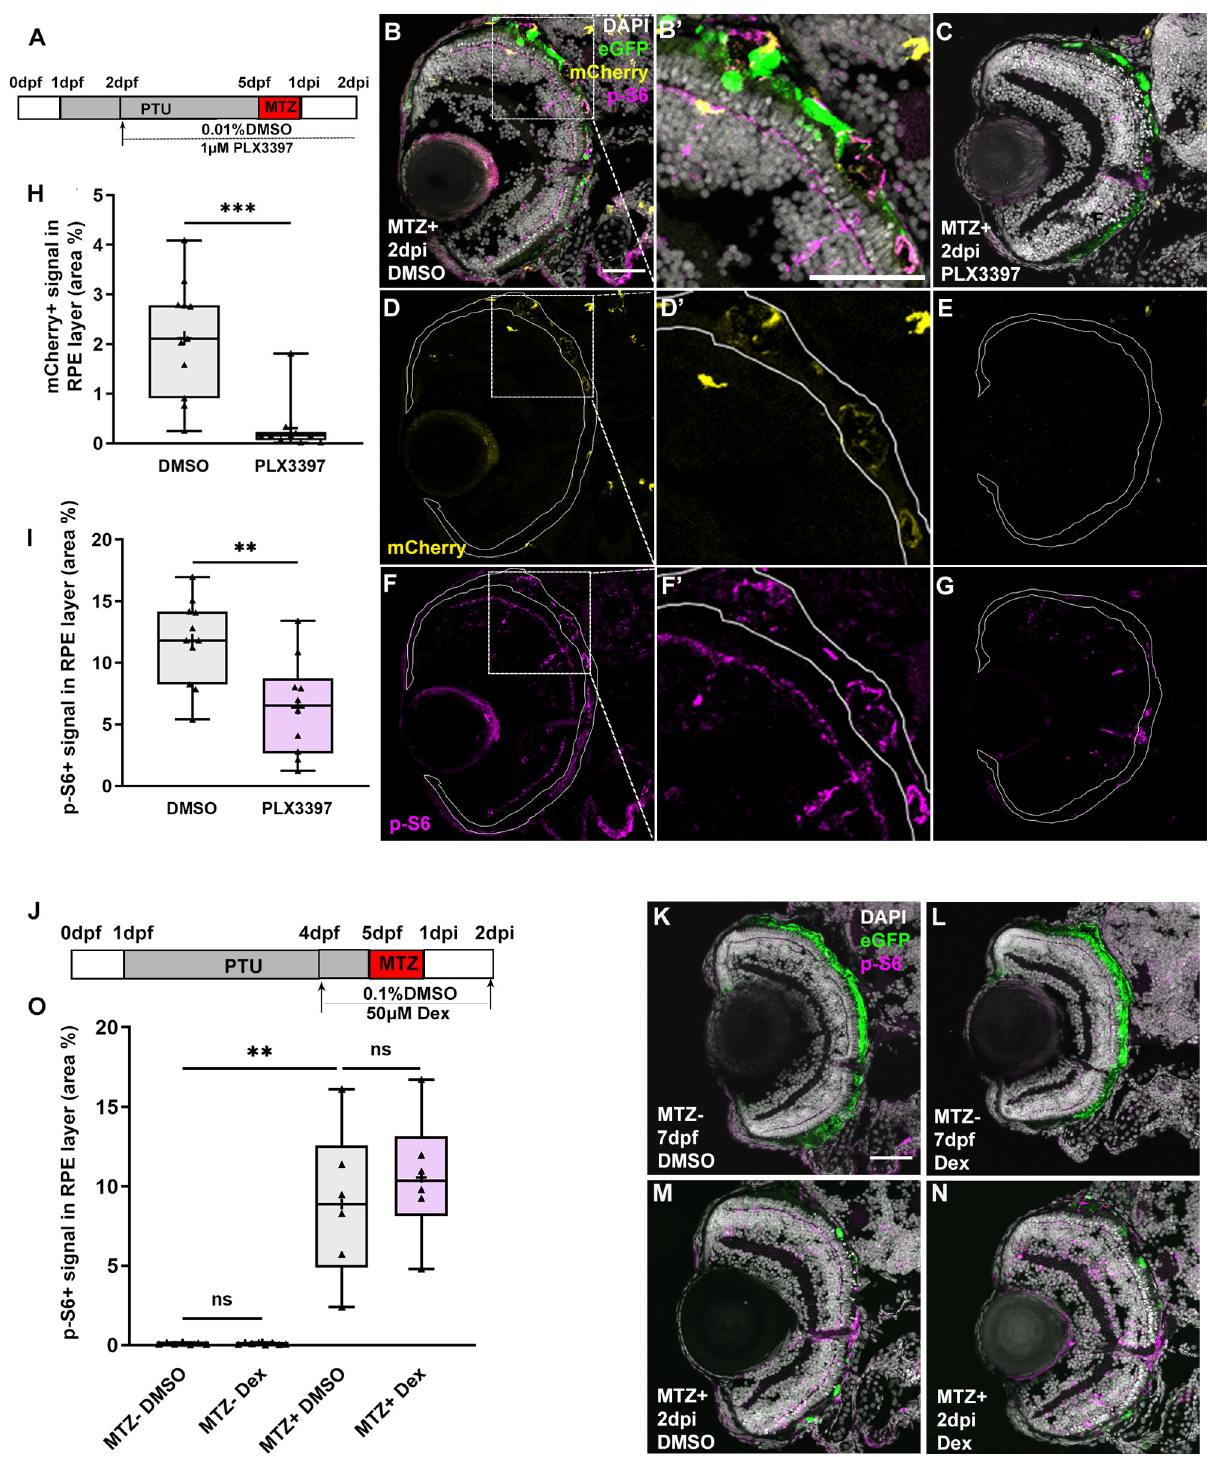
Fig 7. Macrophage/microglia function is required for the maintenance of mTOR activity in an inflammation-independent manner. (A,J) Schematic of the experimental paradigm showing the timeline for chemical treatments and ablation on transgenic larvae ( mpeg1 :mCherry; rpe65a :nfsB- eGFP). (B-G) MTZ + DMSO- and PLX3397-treated larvae at 2dpi. Single channel immunofluorescent images of mCherry (D,E) and p-S6 (F,G) are shown. (B’,D’,F’) are high-magnification images showing the colocalization of p-S6 and mCherry. Nuclei (white), eGFP (green), p-S6 (magenta), mCherry (yellow). (H) Quantification of mCherry signal in the RPE layer showed a significant depletion of mCherry + macrophages/microglia in the